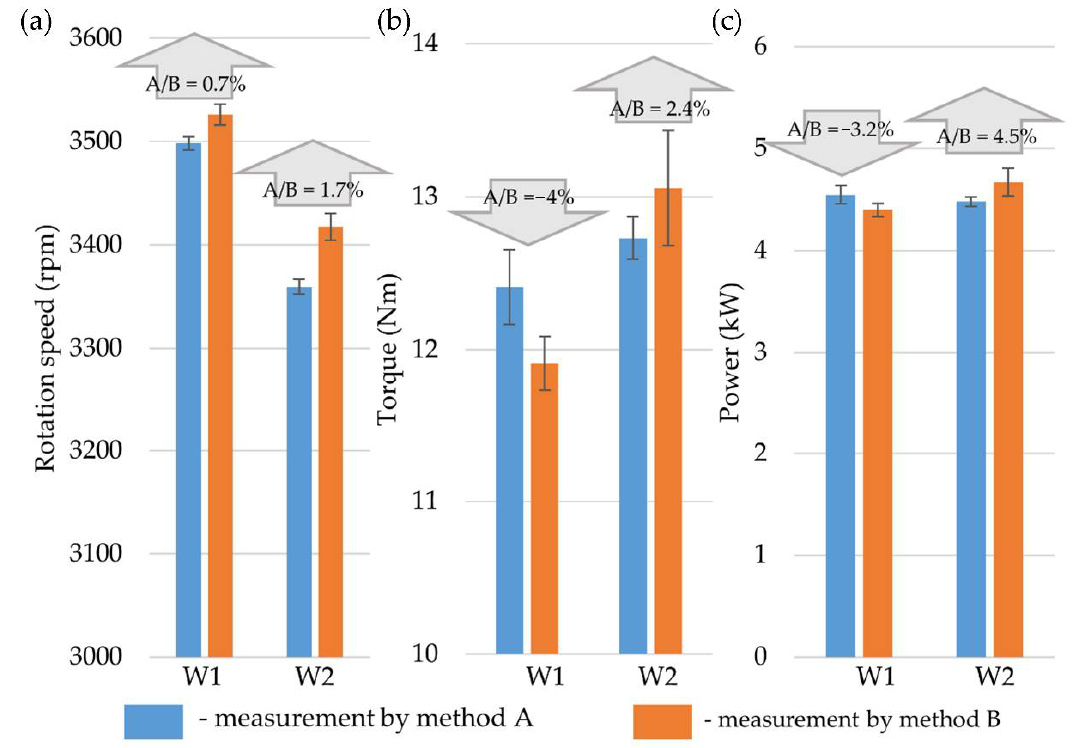
Figure 9. Influence of the measurement method (Method A with open throttle or Method B) on the average values of ( a ) rotational speed, ( b ) torque and ( c ) power, where A/B denotes the difference in the measured values depending on the measurement method.